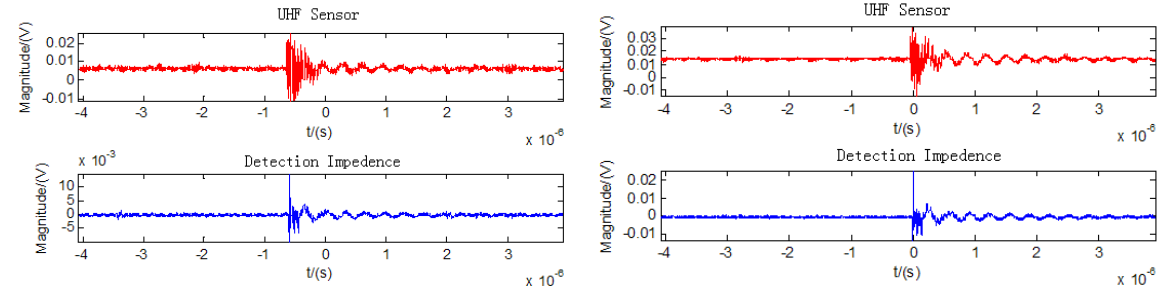
( a ) air-gap insulation defect. ( b ) surface flashover insulation